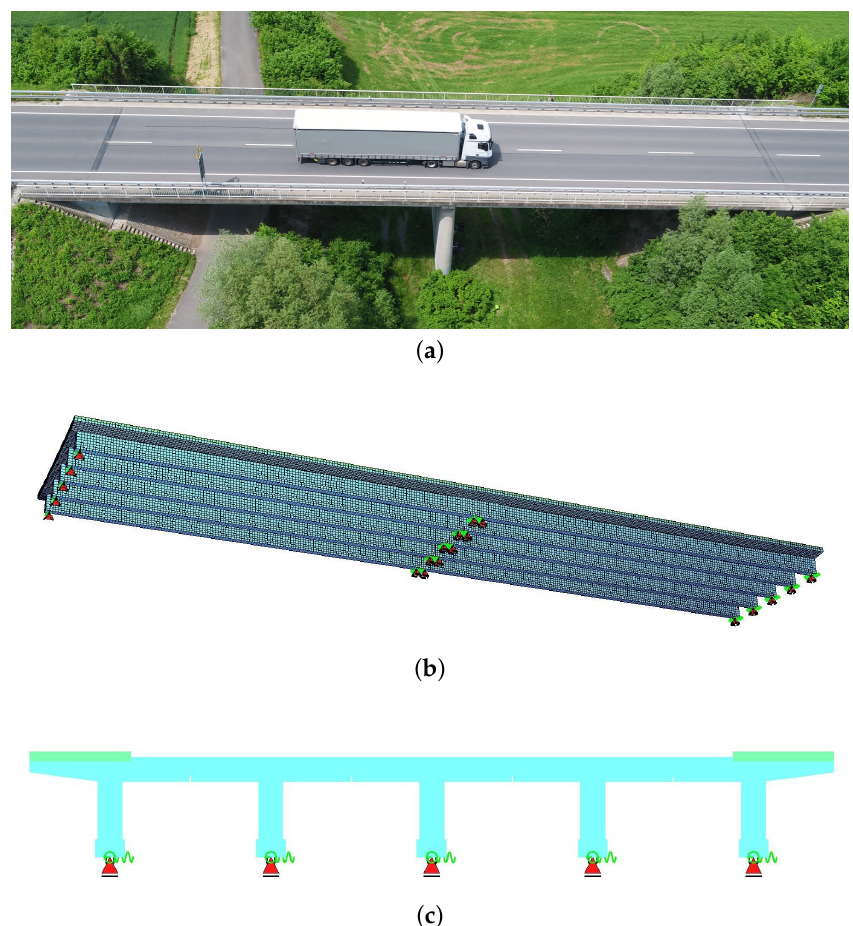
Figure 7. FEM model of the bridge in Dietersdorf near Coburg in Bavaria. The used FEM programme is SOFiSTiK. ( a ) View from above on the example bridge in Dietersdorf on 9 July 2021. ( b ) Isometric view of the bridge from below. The girders of the bridge are not connected to each other. ( c ) Cross- section of the